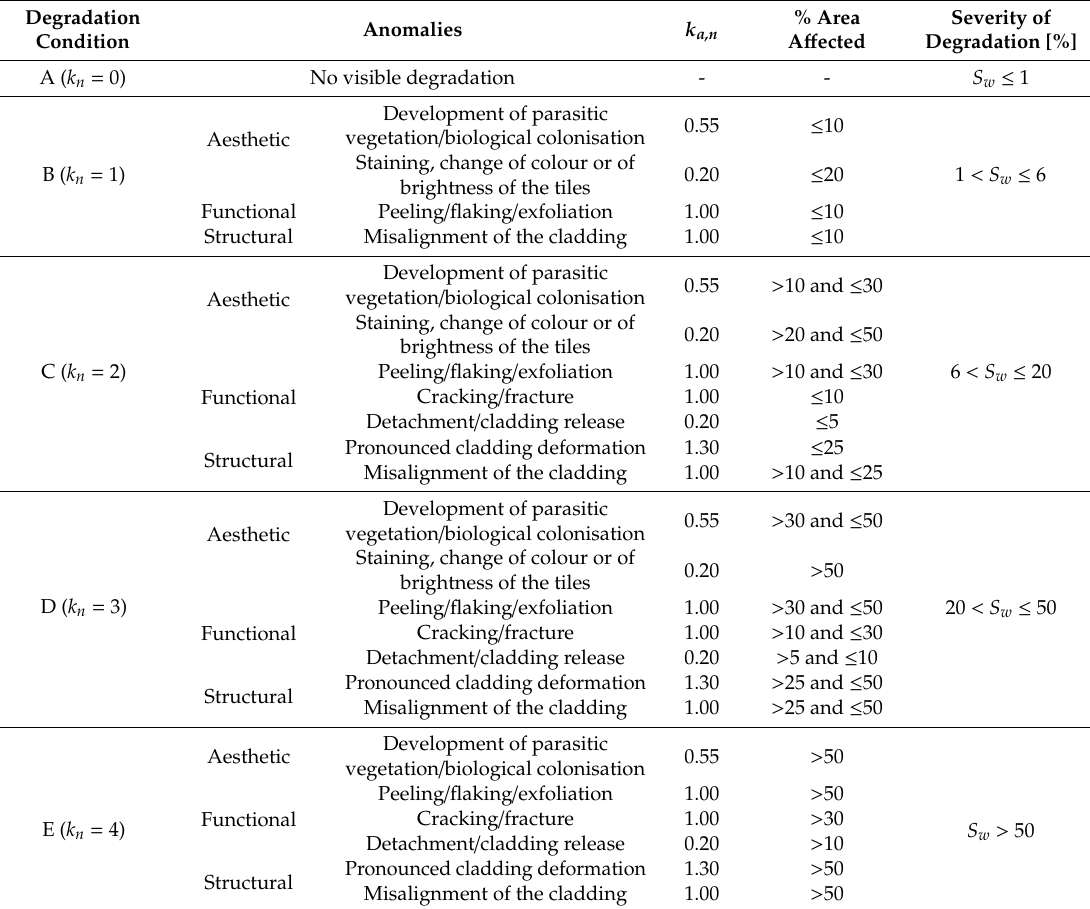
Table 1. Pitched roofs’ ceramic claddings classification system (data adapted from [32]). Degradation